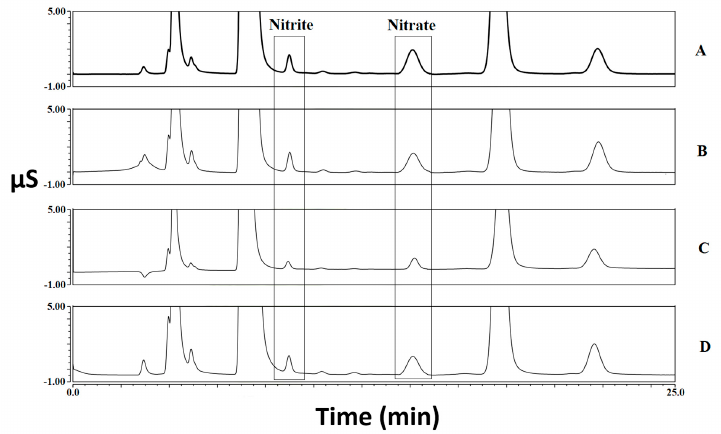
Figure 3. Chromatograms of a chicken wurstel sample both before and after cooking. Nitrite concen- trations in the range 21.8 mg kg − 1 (boiled— C )–46.2 mg kg − 1 (grilled— B ); Nitrate concentrations in